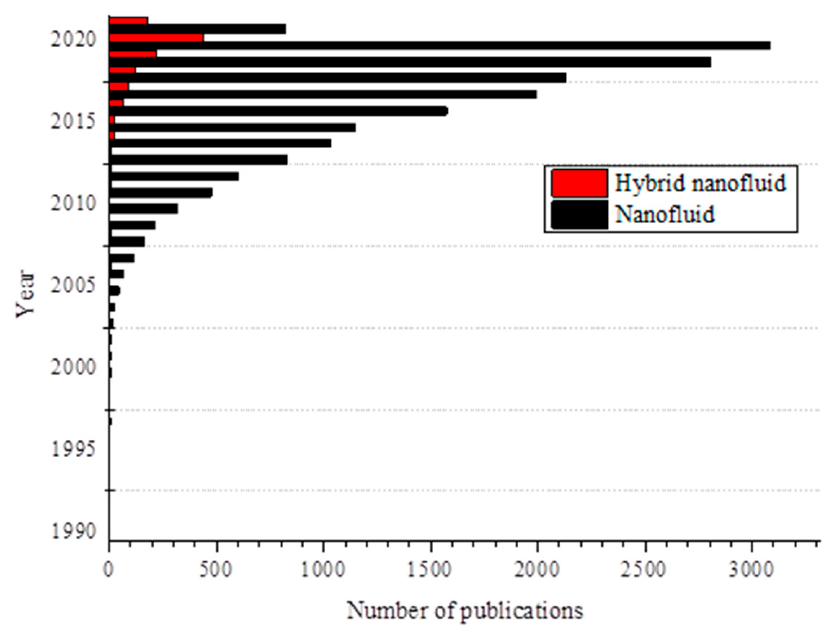
Figure 1. Temporal distribution of publications on nanofluids and hybrid nanofluids (Scopus: 20 May 2022).